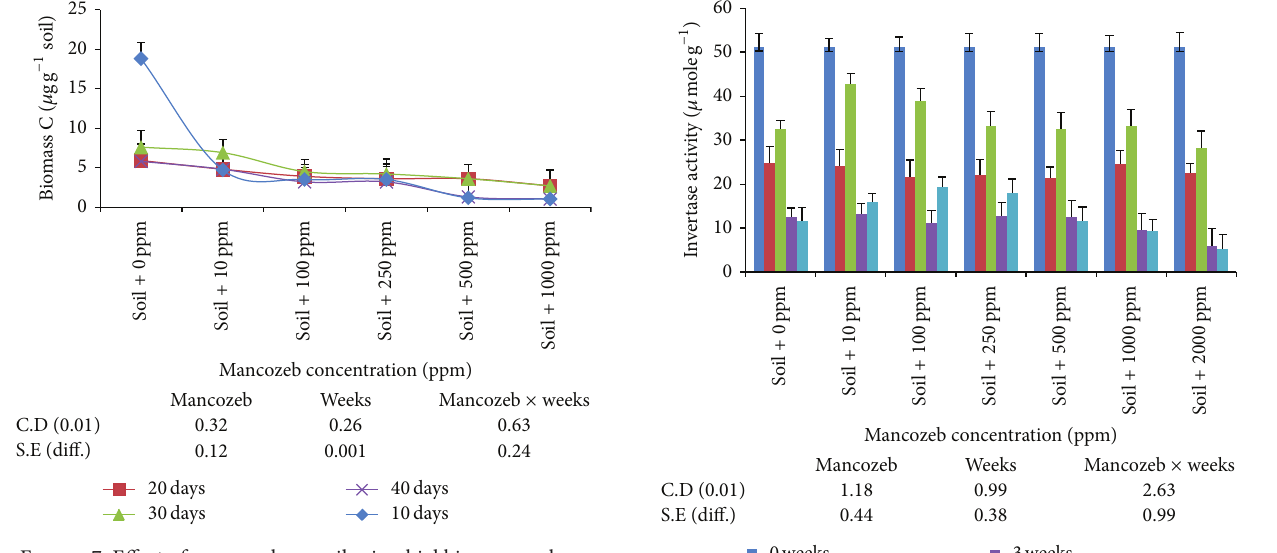
Figure 7: Effect of mancozeb on soil microbial biomass carbon.